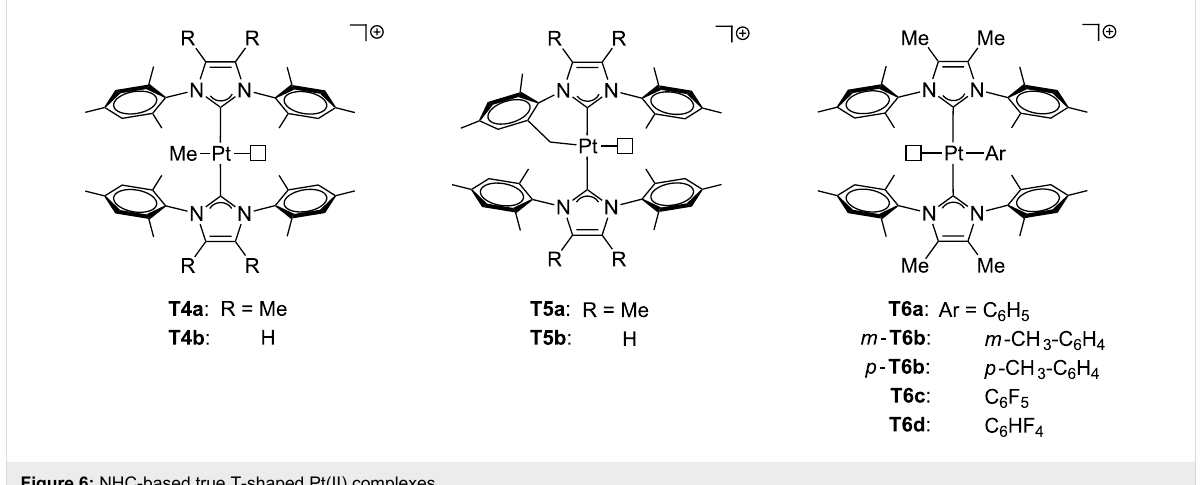
Figure 6: NHC-based true T-shaped Pt(II) complexes.